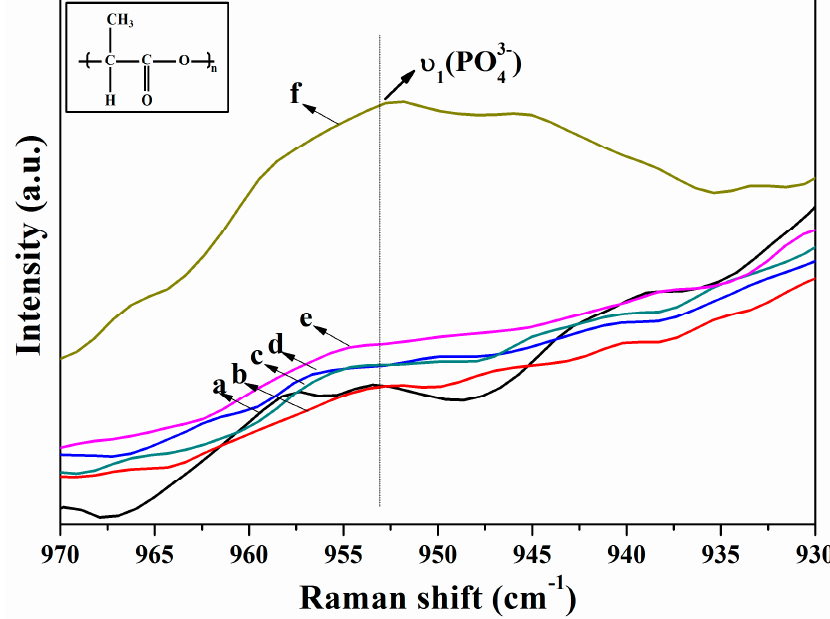
Figure 3. Raman spectra of PLA in the range of 930–970 cm − 1 by being soaked in SBF for different time: ( a ) 0-day; ( b ) 1-day; ( c ) 3-day; ( d ) 5-day; ( e ) 7-day; ( f ) 21-day.